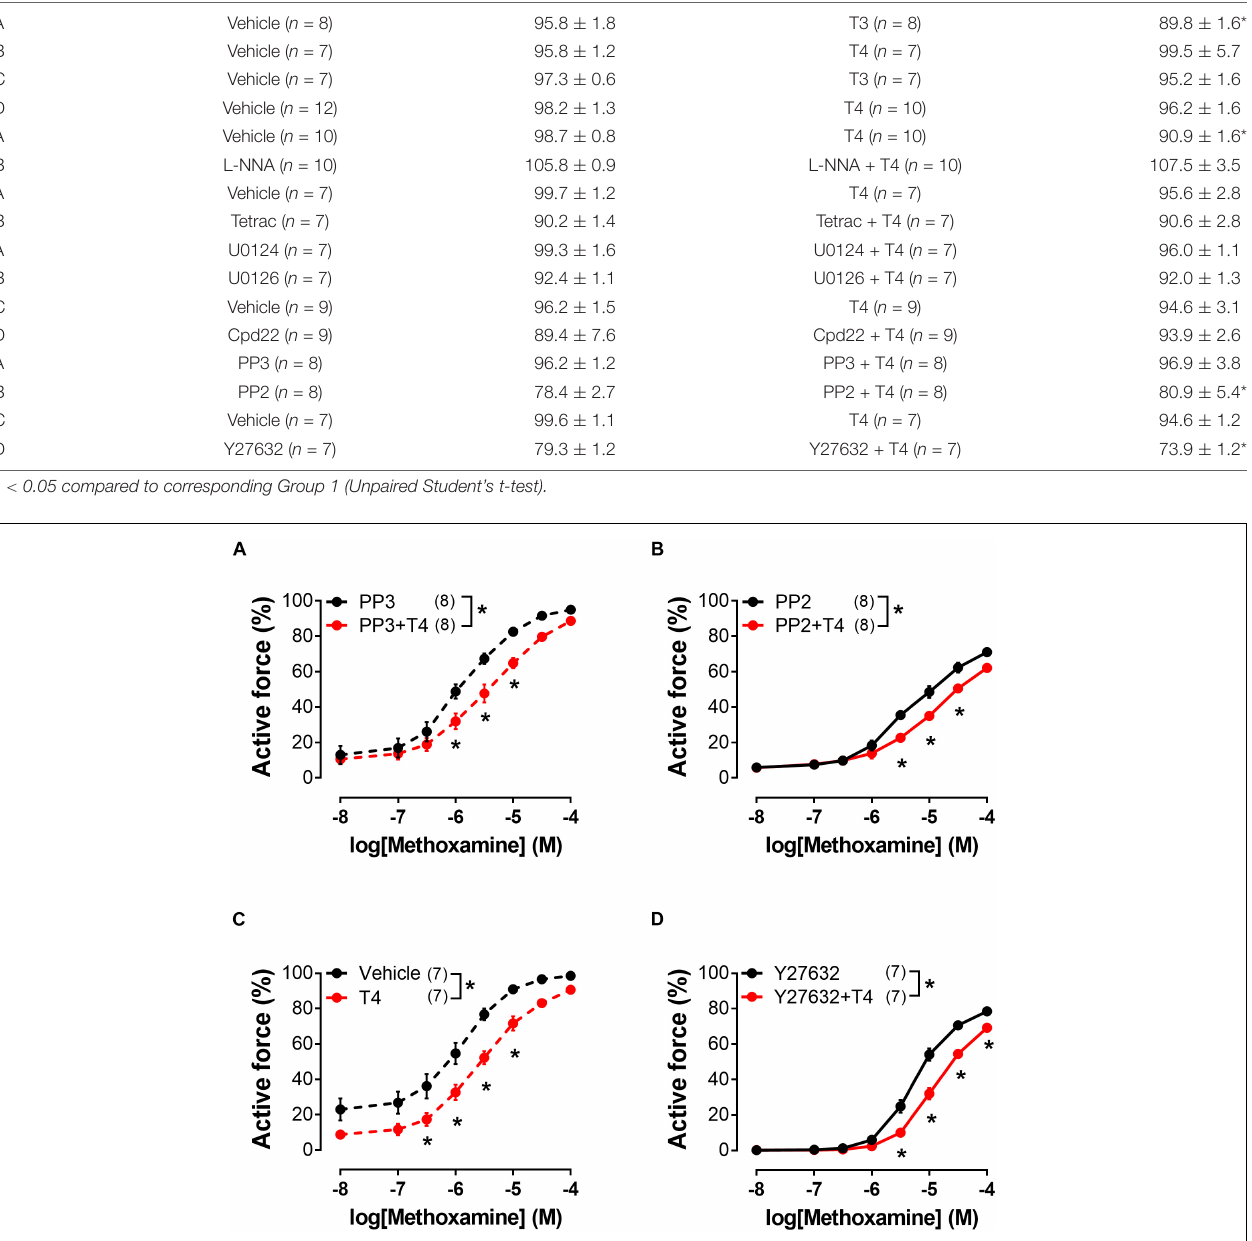
TABLE 2 | Comparison of the maximum response (E max ) calculated for methoxamine concentration-response relationships shown in Figures 2–4 , 6 , 7 . Figure Group 1 Group 2 Treatment E max , % Treatment